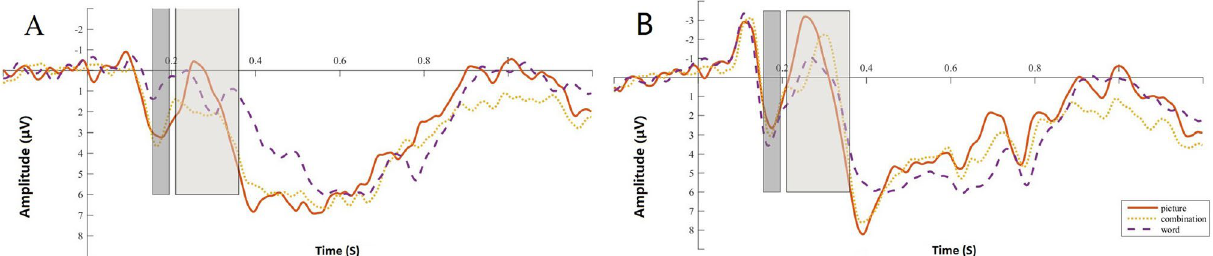
Figure 4. Difference wave and latency in the oddball task: ( A ) difference wave between target and nontarget; ( B ) mean amplitude of target. Shaded areas are the time range of the P2 component (155–195 ms) and N2 component (200–350 ms). All of the images of ERPs are the result averaged by six electrodes (FC3, FCz, FC4, C3, Cz, and